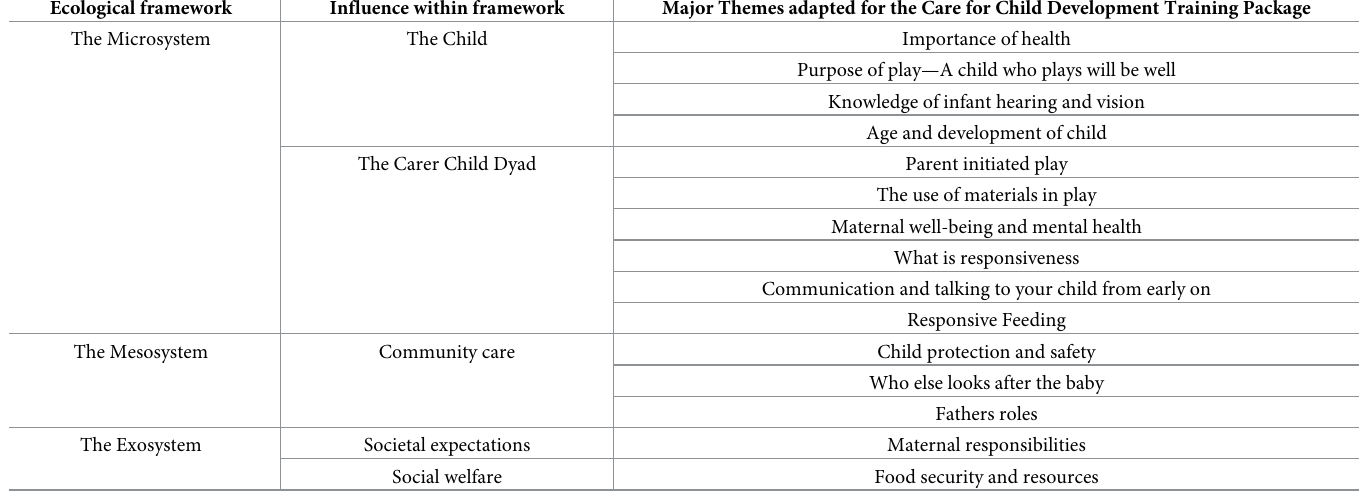
Table 2. Framework and major themes in the care, play and early communication of children less than 2 years in Malawi. Ecological